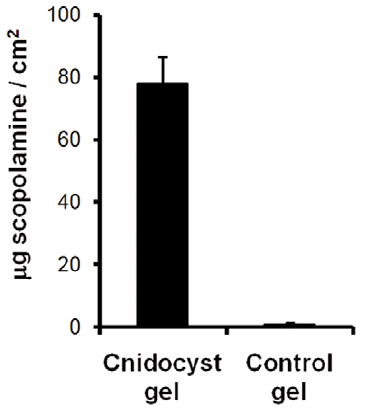
Figure 4. Scopolamine 5-minute in-vitro study. Cumulative permeation of scopolamine delivered by cnidocyst gel ( n =11) compared to control gel without microcapsules ( n =5) after 24 hours. Error bars represent s.d.